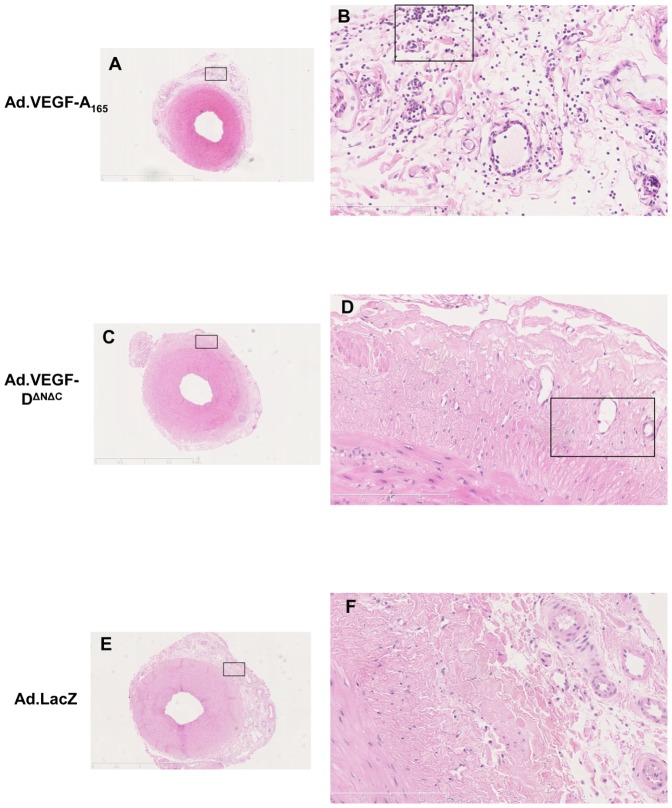
Representative H&E stained pictures of uterine artery sections treated with Ad.VEGF-A165 (A,B), Ad.VEGF-DΔ
NΔC (C,D) or Ad.LacZ (E.F).The boxed areas in pictures A, C and E have been magnified in pictures B, D and F respectively. The boxed areas in pictures B and D have been magnified in Figure 8.